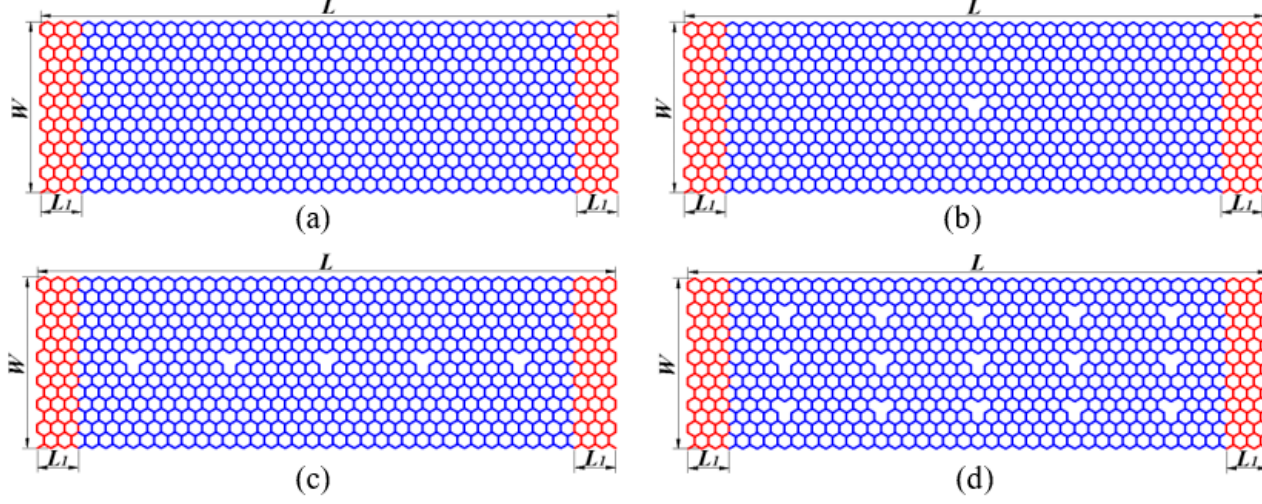
Figure 1. Atomic structures of ( a ) Perfect, ( b ) Single vacancy, ( c ) Low-concentration vacancies, and ( d ) High-concentration vacancies graphene